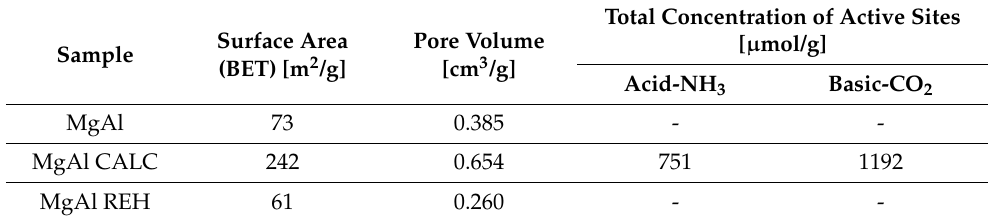
Table 2. Textural and acid-based properties of tested catalysts for aldol condensation.